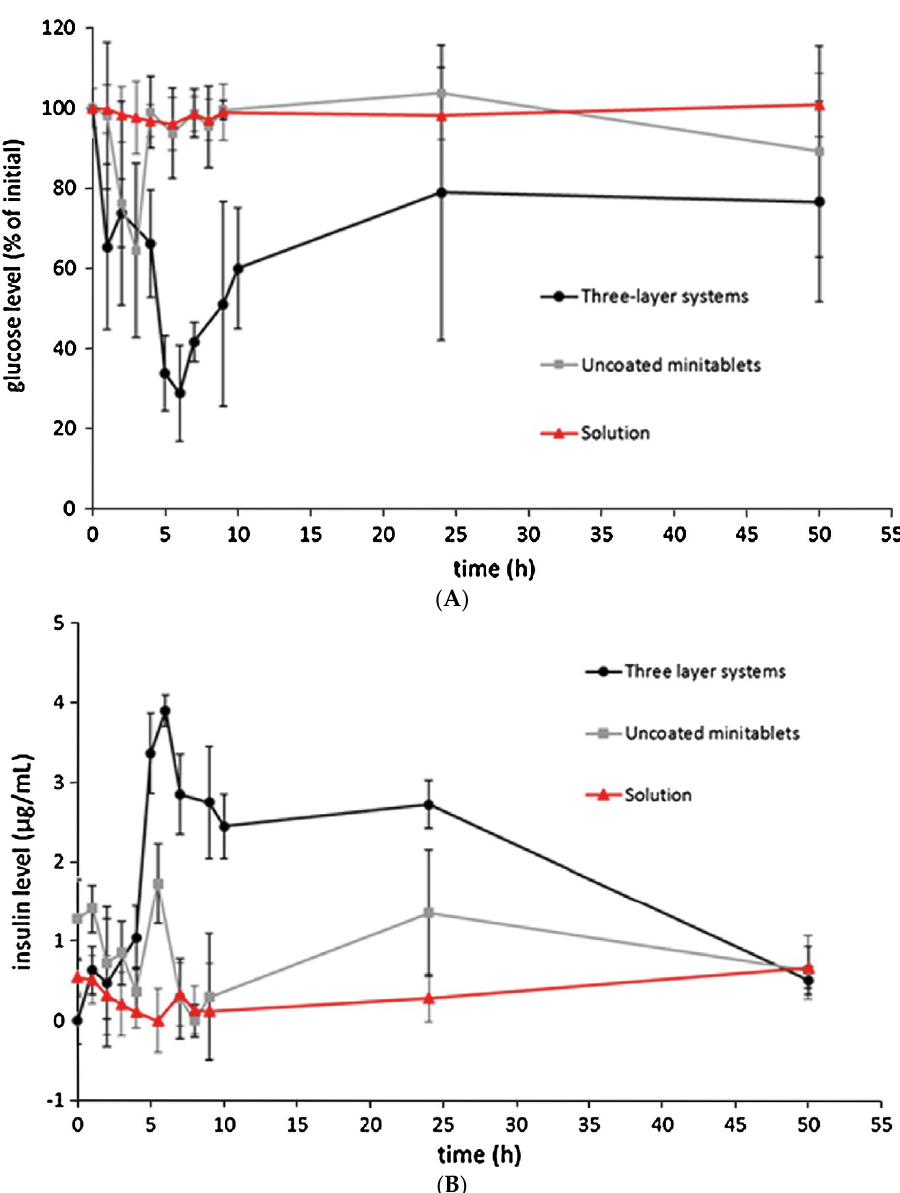
Figure 33. Plasma glucose ( A ) and insulin ( B ) concentration profiles in diabetic rats following oral administration of minitablet-based Chronotopic ® systems, uncoated minitablets or insulin in solution (bars indicate standard deviation). Reprinted with permission from Ref. [74]. 2016, Elsevier.